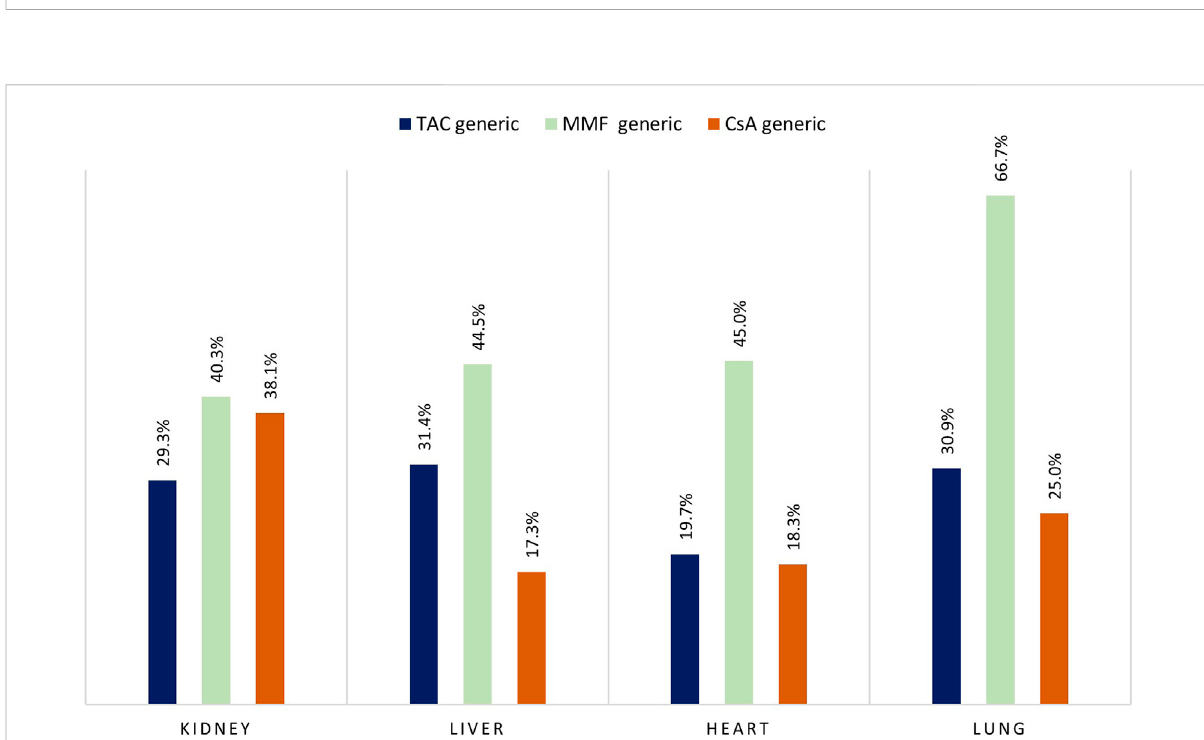
FIGURE 7 Percentage of branded versus generic drug for tacrolimus (TAC), mycophenolate (MMF), and cyclosporine (CsA) by type of organ transplant. Note: Only patients enrolled in the period where both brand and generic version of the drug were available were included in the